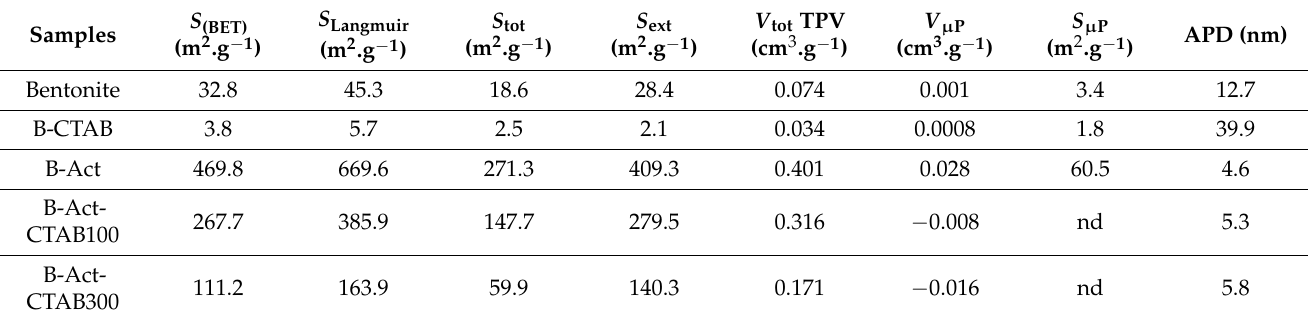
Figure 4. N 2 adsorption-desorption isotherms of bentonite and all modified bentonites. Table 3. Specific surface area ( S BET ), external surface area ( S EXT ) and micropore volume ( V µ P ) of bentonite and all modified bentonite clays. S tot : Total surface area derived from the slope of the straight line passing through the origin of the t-plot. V µ P : Liquid micropore volume derived from the ordinate at the origin in the second straight line of the t-plot. S µ pt micro: Surface area out of micropores derived from the slope of the second straight line of the t-plot. V tot : Total pore volume (TPV), derived from the amount of nitrogen adsorbed at P = P 0 =